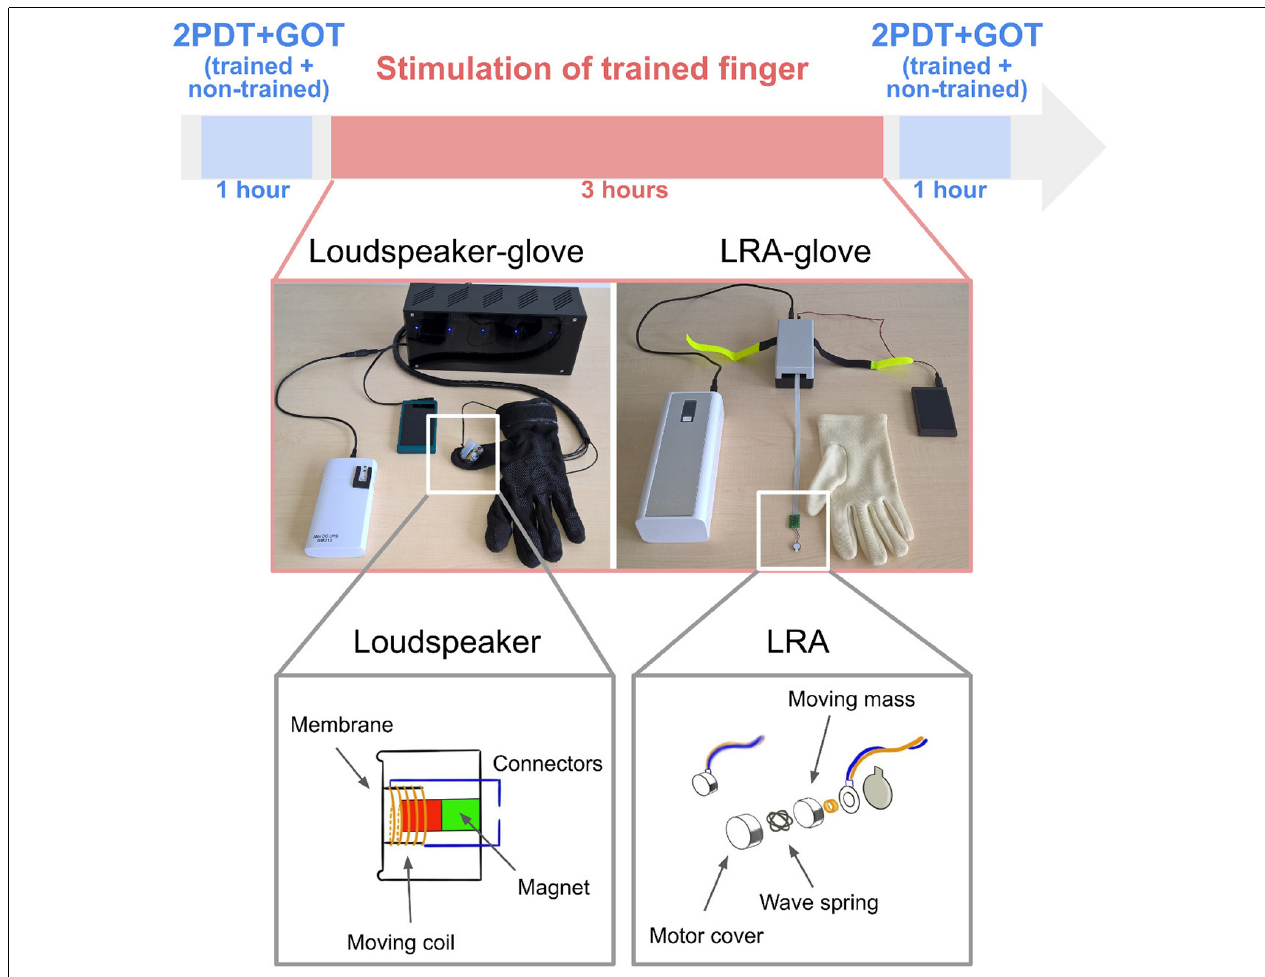
FIGURE 1 | Experimental design and glove systems. Participants were first tested in the two-point discrimination task (2PDT) and the grating orientation task (GOT) both at the index finger and at the middle finger. While wearing the glove, they were then stimulated for 3 h at the trained finger only (index finger for half of the group, middle finger for the other half) using either loudspeaker-based somatosensory stimulation (left) or LRA-based somatosensory stimulation (right). The non-trained finger was covered in the glove, but the stimulation module was off. After the stimulation, participants were tested again in the 2PDT and the GOT both at the trained finger and the non-trained